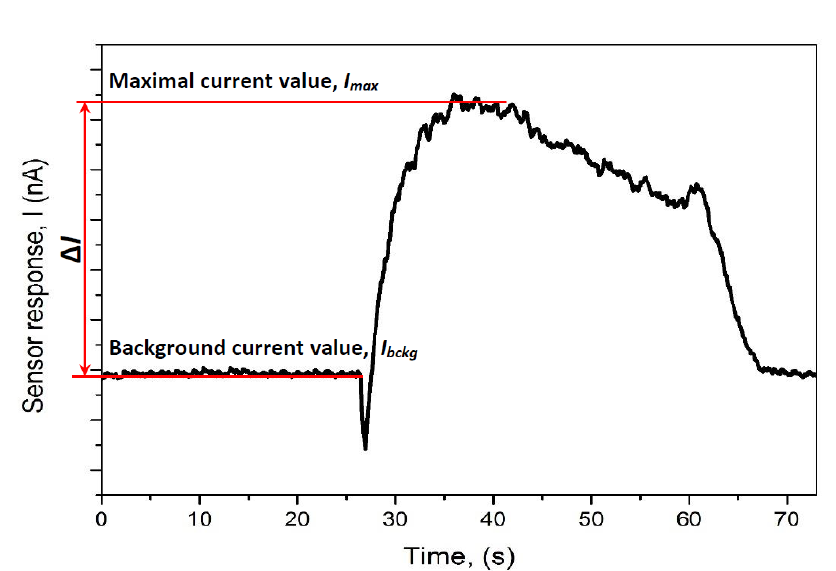
Figure 2. Assessment of steady-state based analytical signal (Δ I ) from a typical WO 3 /WO 3−x -based sensor response towards vapor of different VOCs (methanol, ethanol, isopropanol, acetone) and ammonia gas at temperatures between 60 and 270